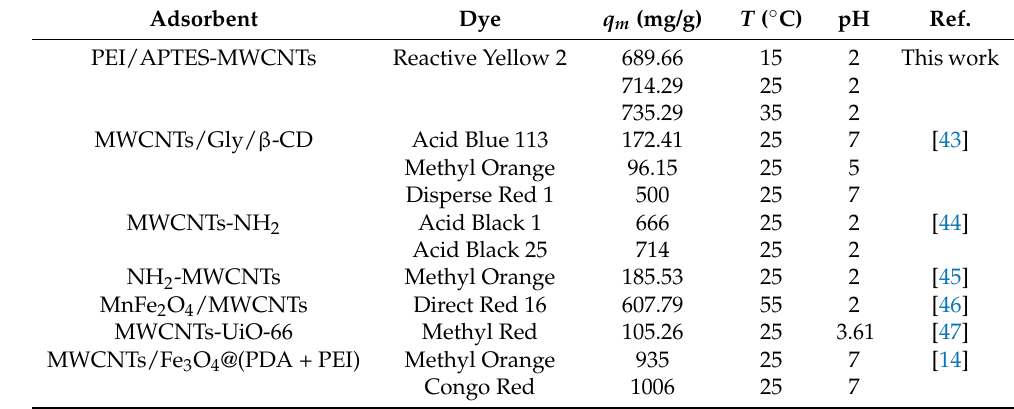
Table 4. Comparison of the adsorption capacities of functionalized MWCNTs for anionic